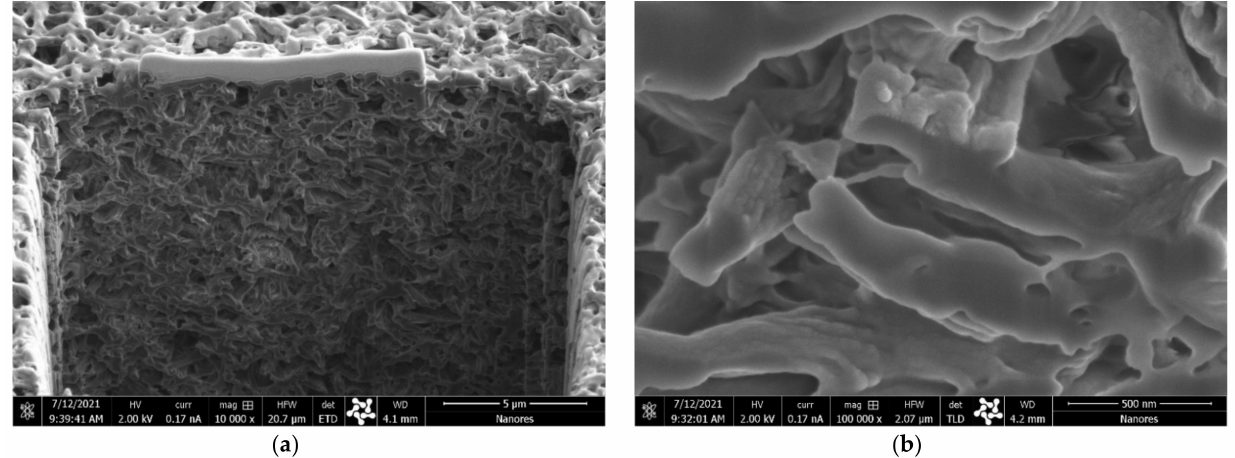
Figure A9. SEM images of the cross section of a polyamide membrane with 43% carvacrol (bar = 5 µ m ( a ), bar = 500 nm ( b